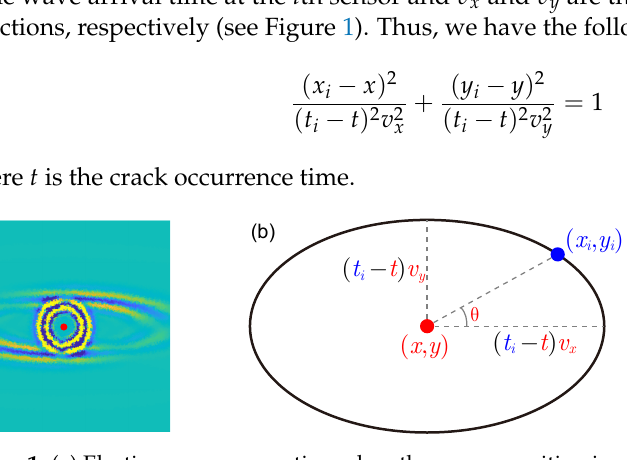
Figure 1. ( a ) Elastic wave propagation when the source position is a red dot in an anisotropic object, whose lateral elastic wave velocity is higher than that in the vertical direction. ( b ) An elliptical wave having a source at the location ( x , y ) at time t arrives at the sensor ( x i , y i ) at time t i . The horizontal and vertical velocities of the elliptic wave are v x and v y ,